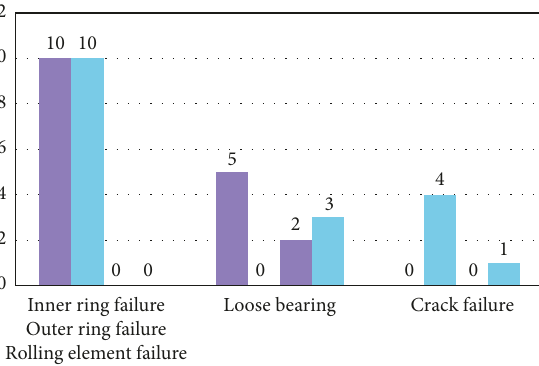
Figure 4: Fault diagnosis